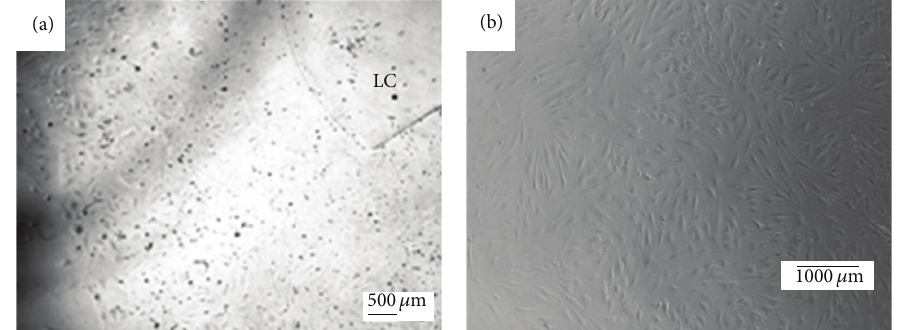
Figure 2: Examples of attached human eye explants with the growing cells: (a) anterior lens capsule (aLC) in a 12-well plate; (b) fibrovascular epiretinal membrane (fvERM) cells growing attached to and independently from the tissue explant in a cell culture Petri